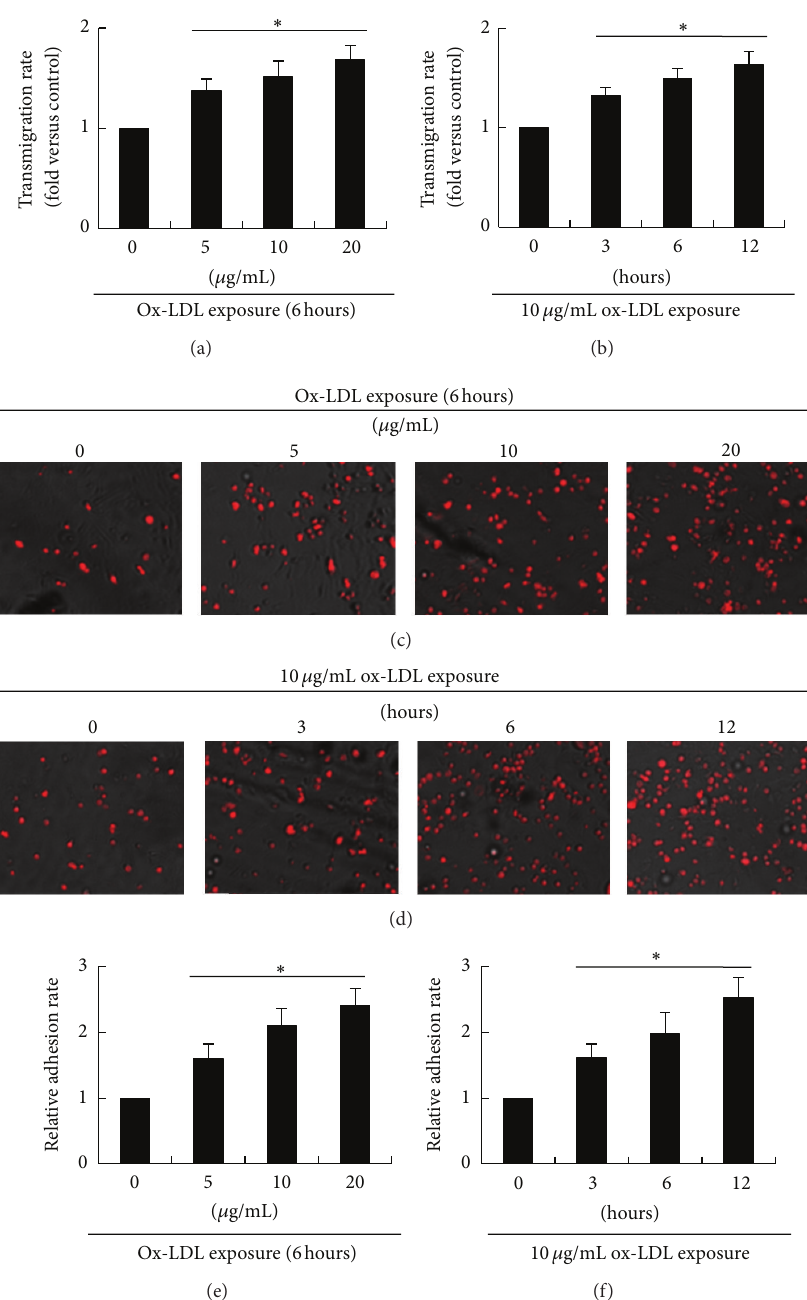
Figure 2: Ox-LDL promotes transmigration of bmMSCs and enhances cell adhesion between bmMSCs (grey color) and monocytes (red color). (a) Transmigration rates of bmMSCs after exposure to 0, 5, 10, and 20 𝜇 g/mL ox-LDL for 6 hours; (b) transmigration rates of bmMSCs after exposure to 10 𝜇 g/mL for 0, 3, 6, and 12 hours; (c) the merged phase contrast and fluorescence images show adhesion between bmMSCs and monocytes after treatment with 0, 5, 10, and 20 𝜇 g/mL ox-LDL for 6 hours; (d) the merged phase contrast and fluorescence images show adhesion between bmMSCs and monocytes after treatment with 10 𝜇 g/mL for 0, 3, 6, and 12 hours; (e) the relative adhesive rate of monocytes onto bmMSCs after treatment with 0, 5, 10 and 20 𝜇 g/mL ox-LDL for 6 hours; (f) the relative adhesive rate of monocytes onto bmMSCs after treatment with 10 𝜇 g/mL ox-LDL for 0, 3, 6, and 12 hours. Bar graphs represent mean ± SD ( 𝑛 = 4 per group). ∗ 𝑃 < 0.01 versus